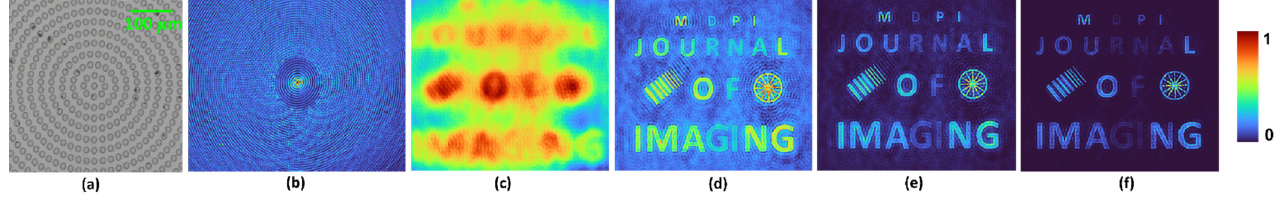
Figure 9. ( a ) Image of the photon-sieve axicon fabricated using femtosecond ablation. ( b ) Recorded PSF, ( c ) object’s response pattern. Reconstruction results using ( d ) NLR ( p = 1), ( e ) NLR ( p = 2) and ( f ) NLR ( p = 3).